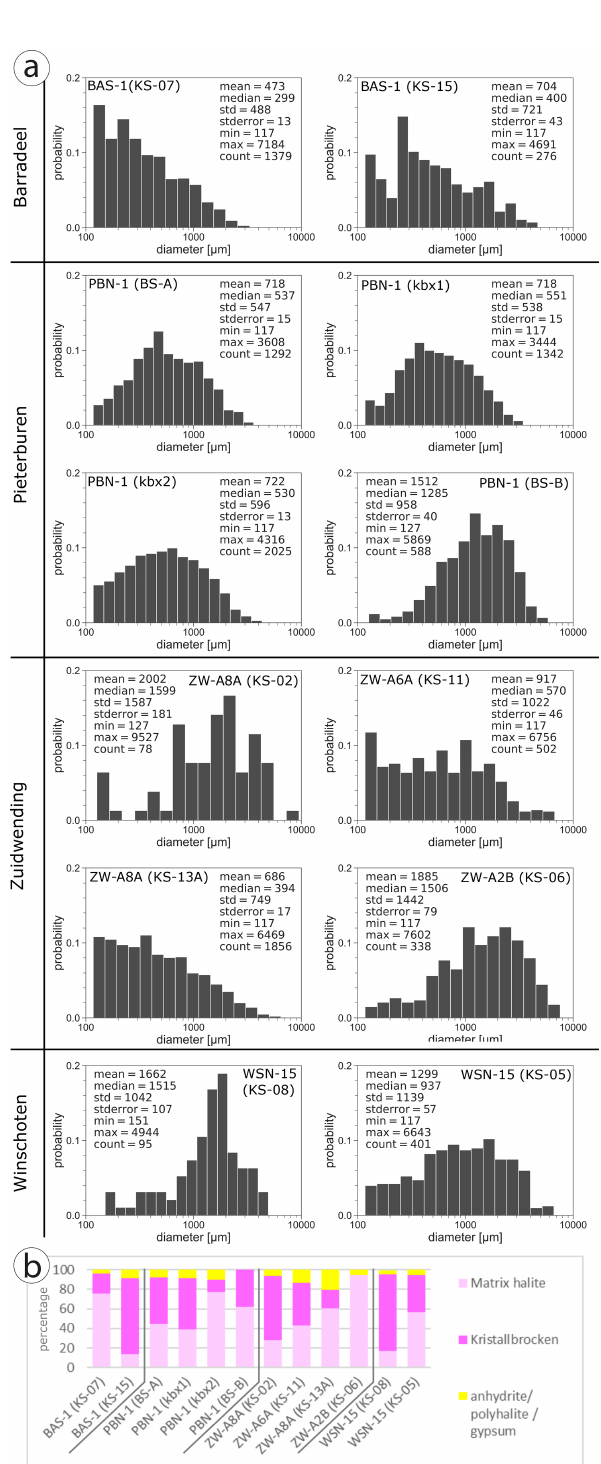
Figure 7. (a) Grain-size histograms of fine-grained matrix halite for each sample presented in Fig. 3 including statistical parame- ters. Grains smaller than 0.117mm were not mapped due to image resolution. (b) Fractions of matrix halite, Kristallbrocken, and an- hydrite/polyhalite and gypsum for each